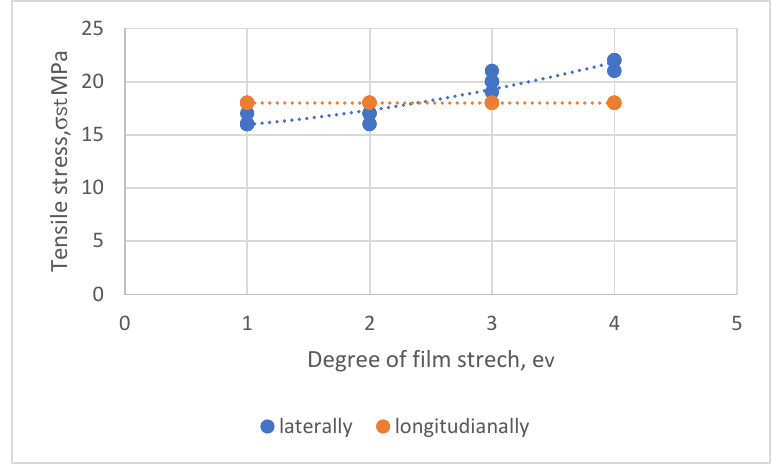
Figure 18. Dependence of tensile strength on the degree of film stretch.